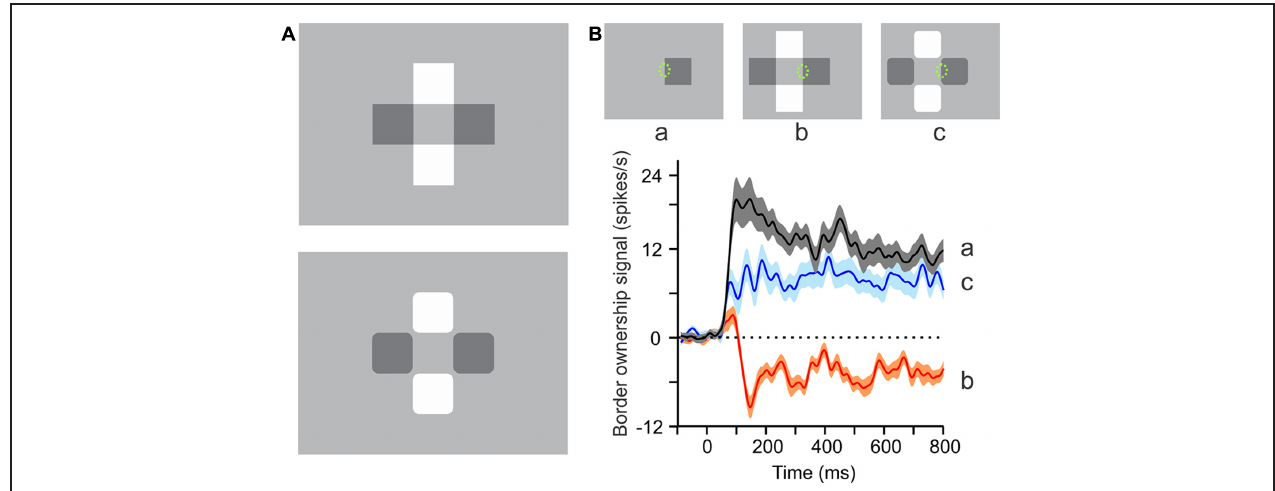
FIGURE 3 | Border ownership signals correlate with perceptual organization. ( A , Top) This configuration of two light and two dark squares is generally perceived as a pair of crossed bars in transparent overlay, or as a light bar with a shadow on it, or a dark bar crossed by a beam of light. However, when the corners of the squares are rounded off, only the individual squares are perceived ( A , bottom). (B) Curves show the average border ownership signals (difference between preferred and non-preferred side responses) for the three conditions shown at the top, where a green ellipse marks the location and approximate size of receptive fields (not part of display). Note the reversals of perceived border ownership of the marked edge between a (owned right), b (owned left), and c (owned right). The neural border ownership signals reverse sign accordingly. (Modified from Qiu and von der Heydt, 2007.)